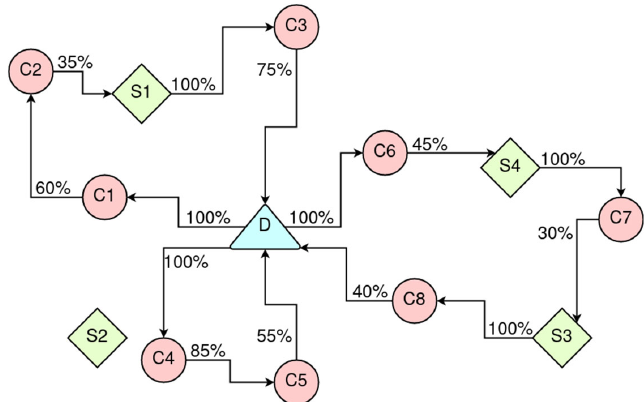
Fig. 1. A generic example of